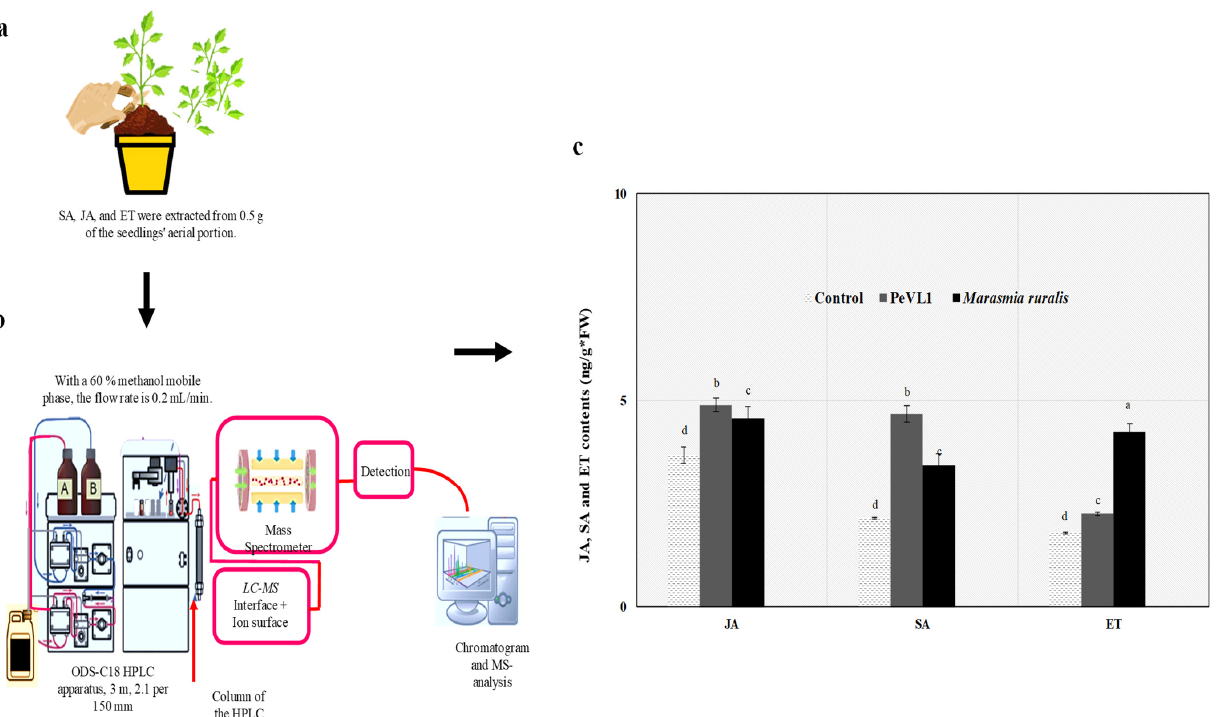
Figure 6. Oryza Sativa seedling JA, SA, and ET levels (mean ± SD). ( a , b ) An additional day after spraying, PeVL1 data were collected. ( c ) Marisma ruralis were infected in both treatments. The LSD, ANOVA, and Leven’s test were used to compare data. Lower-case letters indicate significant JA, SA, or ET treatment differences. ( p = 0.05).